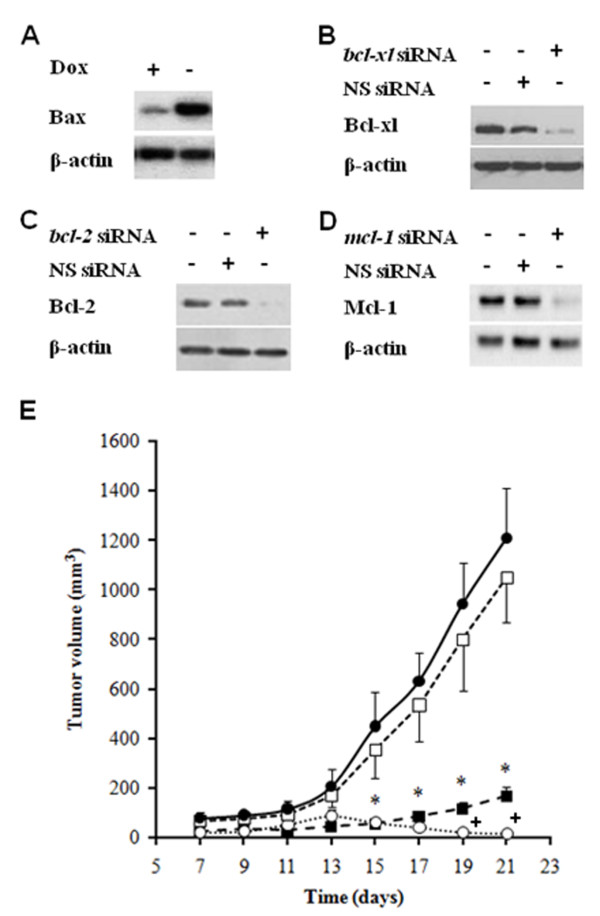
Effect of shRNA-induced bcl-xl, bcl-2, or mcl-1 silencing and of ectopic bax overexpression on A375 xenograft growth. siRNA-induced bcl-xl, bcl-2, or mcl-1 silencing was used for preliminary in vitro experiments, whereas cells stably expressing shRNAs were used for in vivo experiments (see under Methods). (A) western blots of Bax in A375 and A375/Tet-bax cells. (B, C, D) western blots of Bcl-xl, Bcl-2, and Mcl-1, respectively, in A375 cells transfected with bcl-xl siRNA, bcl-2 siRNA, mcl-1 siRNA, or non-specific (NS) siRNA. (E) in vivo growth of A375 (●), A375/bcl-xl-shRNA (■), A375/bcl-2-shRNA (○), and A375/Tet-bax cells (□). Western blots correspond to cultured transfected cells, and are similar to those obtained in extracts of xenografts (see Methods) 1 or 2 weeks after tumor inoculation (not shown), thus indicating stability of each plasmid expression. Tumor growth (E) was measured during a 3-week period. Data are means ± S.D. of 9-10 mice per group. The significant test refers, for all groups (E), to the comparison between A375/bcl-xl-shRNA, A375/bcl-2-shRNA, or A375/Tet-bax cells and A375 controls (*p < 0.01). A375/bcl-2-shRNA was also compared versus the A375/bcl-xl-shRNA group (+p < 0.01) (E). Rates of tumor growth obtained with A375/mcl-1-shRNA cells were not significantly different from those displayed for A375/Tet-bax cells (□) (E) (not shown). Rates of tumor growth obtained with A375 cells transfected with empty Tet-off vector or with NS shRNA were not significantly different from those displayed for untransfected A375 controls (●) (E) (not shown).